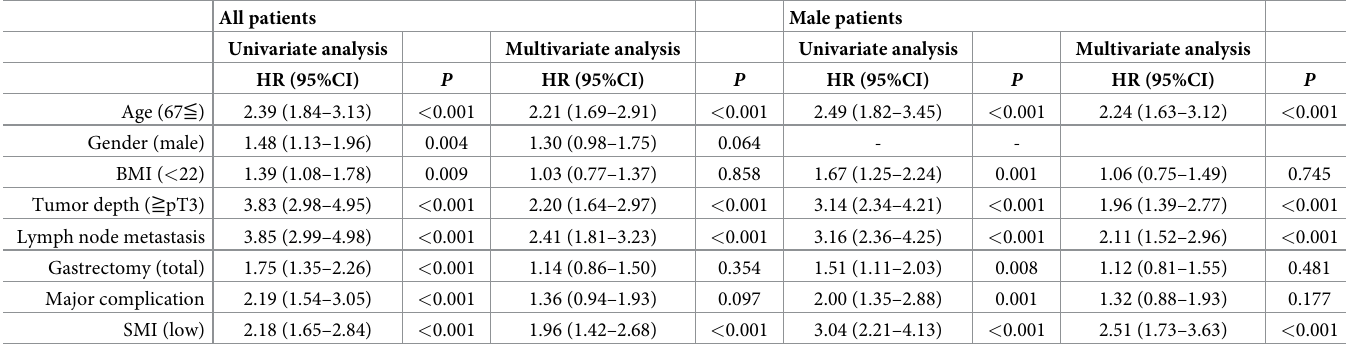
Table 2. Univariate and multivariate analysis of overall survival.